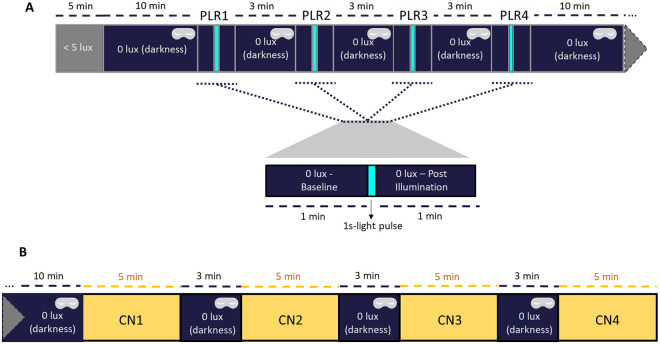
A) Experimental design for pupil light reflex (PLR) assessment and B) color naming (CN) tests.(A) Each pupil recording (PLR) consisted of 1 minute of baseline pupil size in darkness (dark blue areas without eye mask), followed by 1 second light stimulus (turquoise areas) and 1 minute of recovery in darkness (dark blue areas without eye mask). Between each PLR, the participant remained in darkness for 3 minutes, also wearing an eye mask (dark blue areas with an eye mask). (B) Each CN test lasted 5 minutes. Between each CN test, the participant remained 3 minutes in darkness wearing an eye mask (dark blue areas with an eye mask).